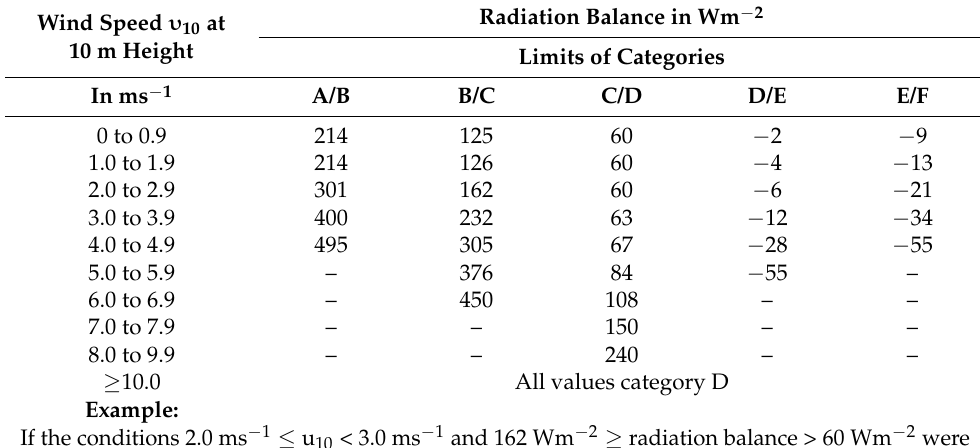
Table 3. KTA scheme to determine stability classes based on the radiation balance and the wind speed (taken from [5]).